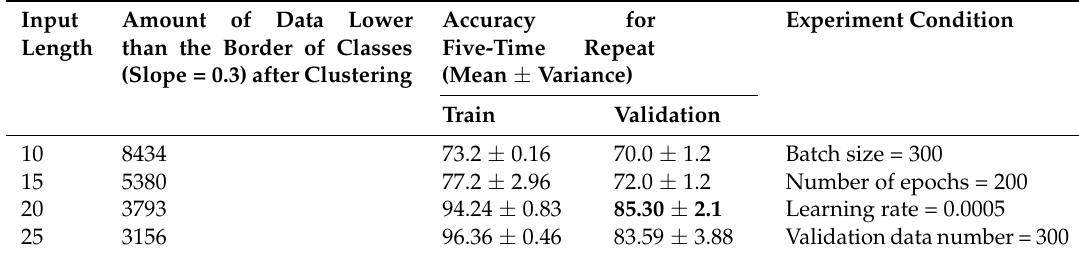
Table 6. Details of experiments into choosing the length of input windows.